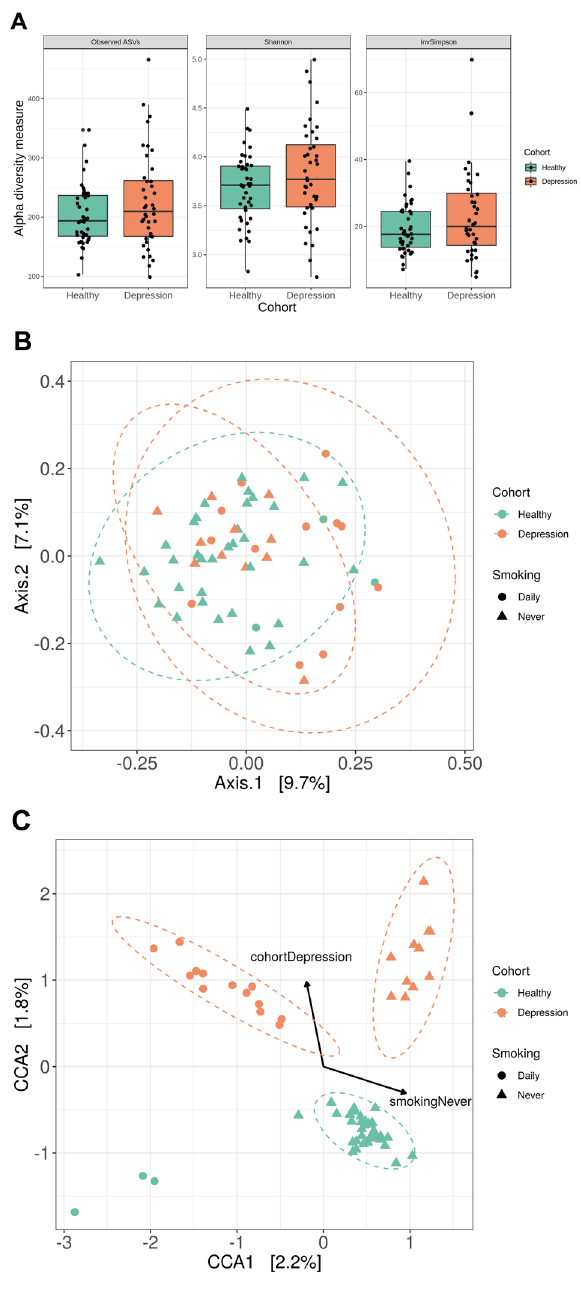
Figure 2. The structure of the oral microbiome in subjects with depression is subtly different compared with controls: ( A ) Shannon diversity is significantly more variable in the depressed cohort (F-test; p < 0.05). However, mean alpha diversity was not significantly different across cohorts for any alpha diversity indices ( B ) Unconstrained analysis of microbiome structure (PCoA) shows no significant clustering between cohorts ( C ) Constrained analysis of microbiome structure shows significant clustering between cohorts. Canonical Correspondence Analysis (CCA) relates samples (dots) to significant environmental variables (lines). The variation that can be explained by each axis is significant (cca anova; smoking p = 0.001; depression p = 0.002). The normal data ellipses (also known as concentration ellipses) serve to highlight clusters of